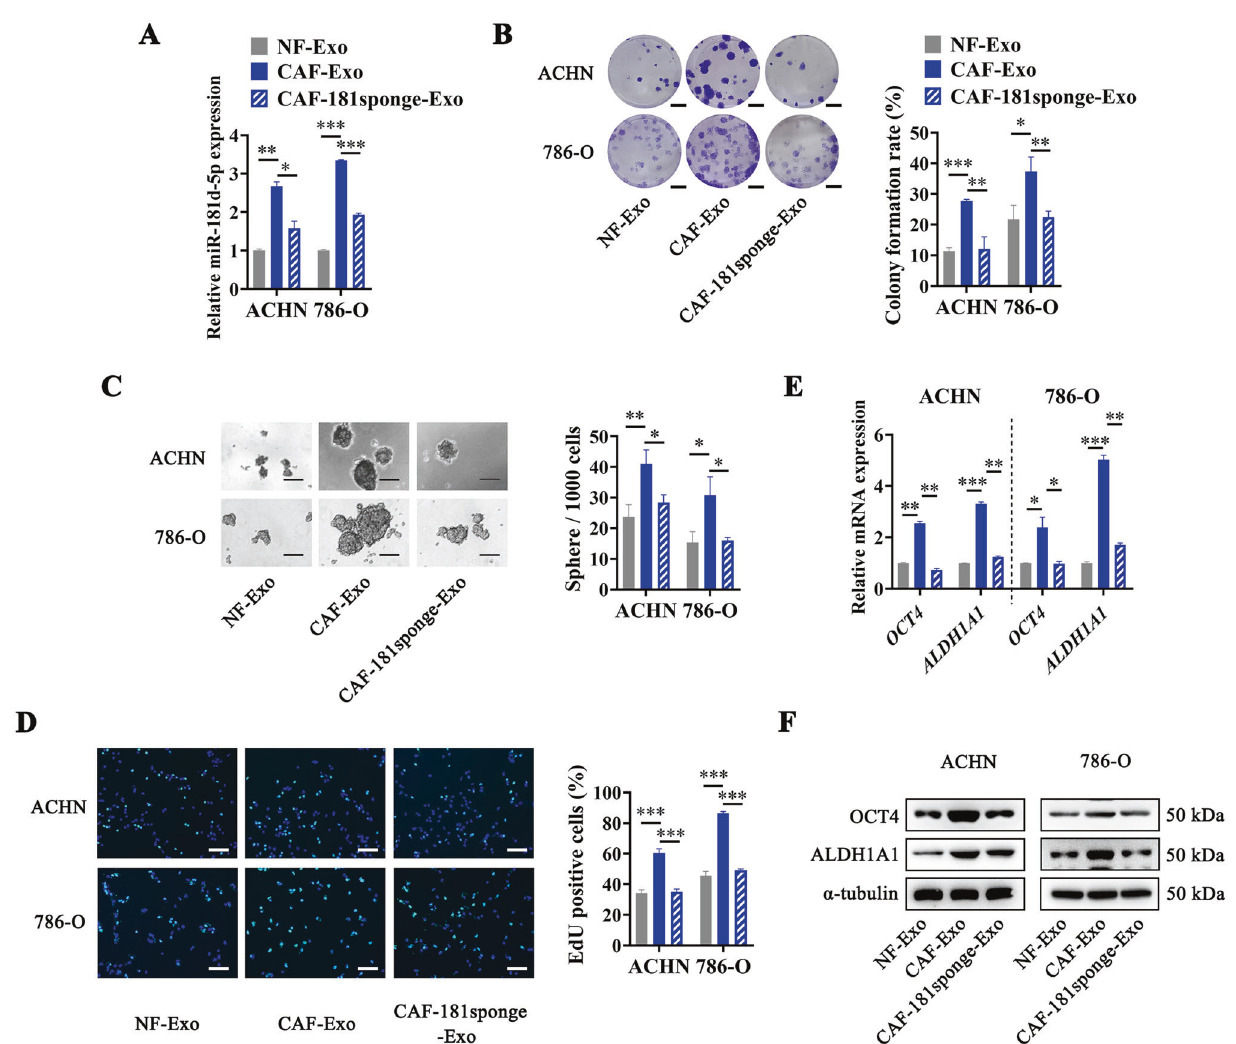
Fig. 6 CAF-secreted exosomal miR-181d-5p enhances the cancer stemness of RCC cells. A RT-qPCR analysis of miR-181d-5p expression in RCC cells treated with NF-Exo, CAF-Exo, or CAF-181sponge-Exo, normalized to U6; B Representative images (Left) and histogram statistics (Right) of colony formation in RCC cells treated with NF-Exo, CAF-Exo, or CAF-181sponge-Exo, scale bar = 0.5 cm; C Representative images (Left) and histogram statistics (Right) of sphere formation in RCC cells treated with NF-Exo, CAF-Exo, or CAF-181sponge-Exo, scale bar = 100 µm; D Representative images (Left) and histogram statistics (Right) of EdU assay in RCC cells treated with NF-Exo, CAF-Exo, or CAF- 181sponge-Exo, scale bar = 50 µm; E RT-qPCR analysis of mRNA levels in RCC cells treated with NF-Exo, CAF-Exo, or CAF-181sponge-Exo, normalized to β -actin ; F Western Blot analysis of protein levels in RCC cells treated with NF-Exo, CAF-Exo, or CAF-181sponge-Exo, normalized to α -Tubulin. Cell experiment was repeated three times independently, P value between two groups was obtained by Unpaired t test. * P < 0.05; ** P < 0.01; *** P < while blocking miR-181d-5p in RCC cells obviously decreased N-cadherin protein expression and enhanced the E-cadherin protein expression (Supplementary Fig. 3C). Hence, these results proved miR-181d-5p could also promote the migration, invasion, and EMT of RCC cells.